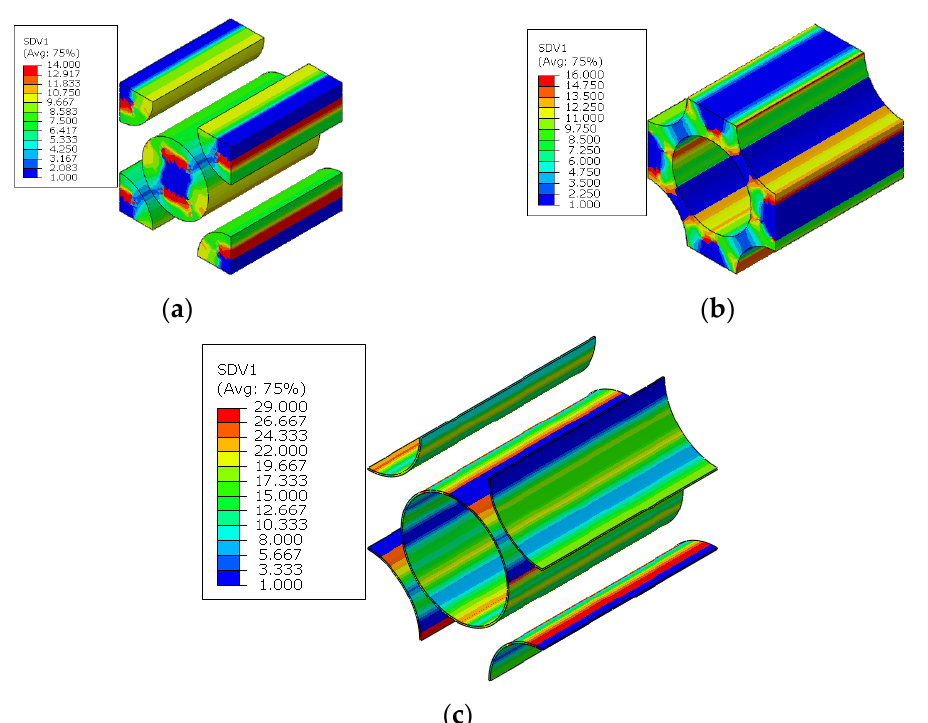
Figure 11. Cluster distribution pattern for the fiber diamond distribution model. ( a ) fiber cluster; ( b ) matrix cluster; ( c ) interface cluster.